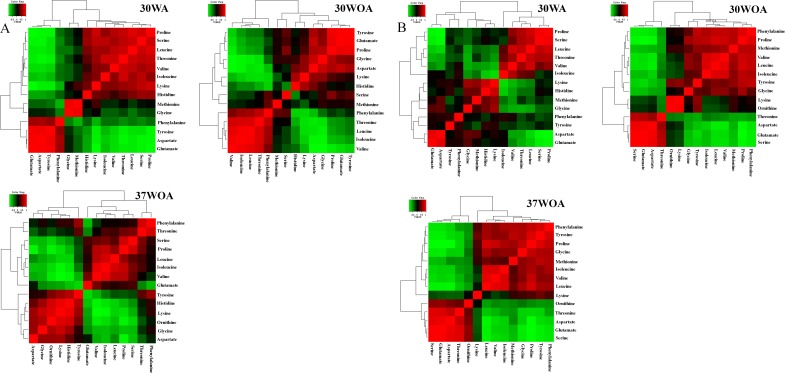
The correlation matrices of PAA profiles using Pearson correlation analysis (r).L. lactis was grown on 20%/80% (wt/wt) of [U-13C] glucose and unlabeled glucose (A) and 20%/80% (wt/wt) of [U-13C] glucose and [1-13C] glucose (B) at 30WA, 30WOA and 37WOA. Ornithine was included in the analysis. 30WA represents 30 °C with agitation, 30WA represents 30 °C with agitation, 30WOA represents 30 °C without agitation and 37WOA represents 37 °C without agitation.